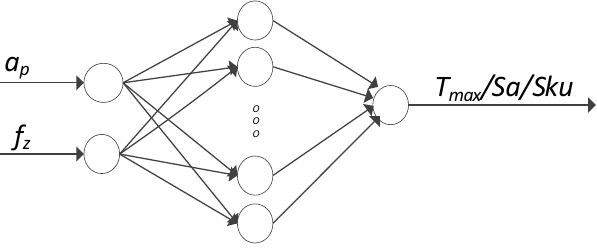
Figure 2. Schematics of the artificial neural network with the analysed process parameters. Two types of MLP (Multilayer Perceptron) and RBF (Radial Basis Function) networks were used to model the above parameters, the parameters of which are presented in Table 1. The Statistica Neural Networks software was used as the modelling